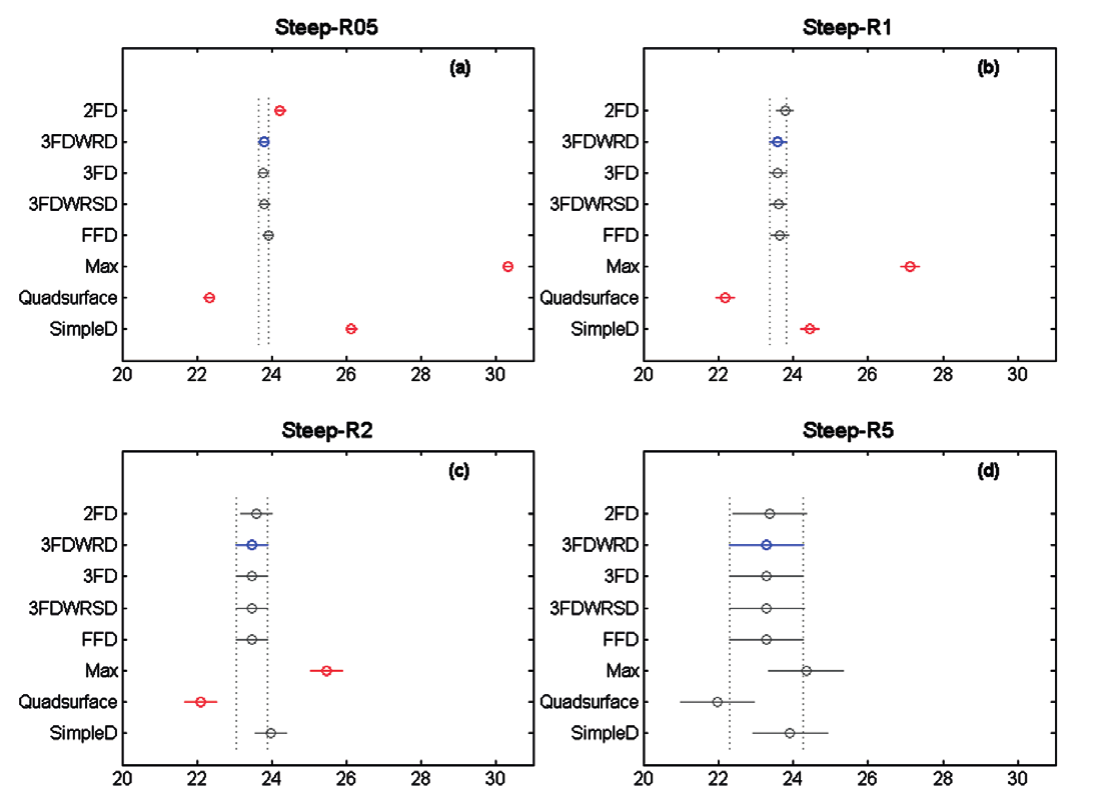
Fig. 5. Pair-wise comparisons of eight algorithms at four levels of resolution in the steep area. Steep-R05 represents 0.5 meter resolution in the steep